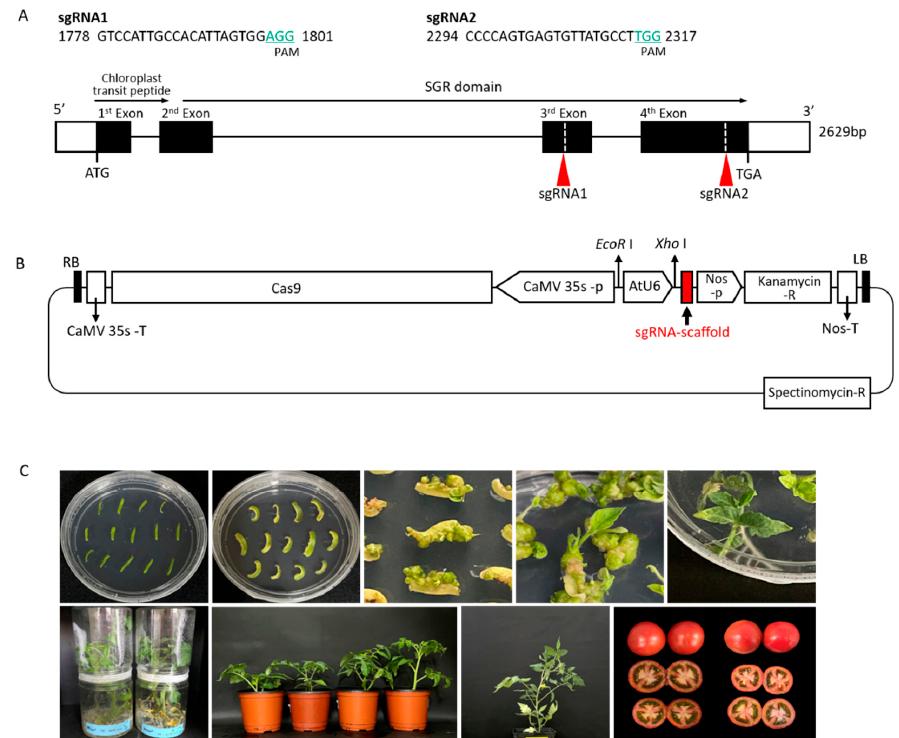
Figure 1. Clustered regularly interspaced palindromic repeat (CRISPR)/CRISPR-associated protein 9 (Cas9)-induced Solanum lycopersicum stay-green 1 ( SlSGR1 ) gene editing. ( A ) Schematic of the single guide RNA (sgRNA) target site in the genomic region of SlSGR1 . ( B ) Ti-plasmid vector construction of sgRNA region for gene editing in tomato. ( C ) Generation of edited lines of SlSGR1 gene using the CRISPR/Cas9 system. Red arrows indicate the sgRNA1 and sgRNA2 regions. We generated 87 and 69 T 0 transformants for the constructs containing gRNA1 and gRNA2, respectively, and confirmed T 0 transformants harboring target mutations for both constructs via polymerase chain reaction (PCR)-based genotyping (Figure 2A; Table 1). and homozygous SlSGR1 mutations were present in the T 0 generation (Figure 2B). Most mutants exhibited 1–19 bp in-frame deletions at the target site, but some mutants showed in-frame additions of 1 bp. Table 1. Frequencies of transgenic plants and genotypes of the target gene region based on genome editing of Solanum lycopersicum stay-green 1 ( SlSGR1 ) gene using the clustered regularly interspaced palindromic repeat (CRISPR)/CRISPR-associated protein 9 (Cas9) system.